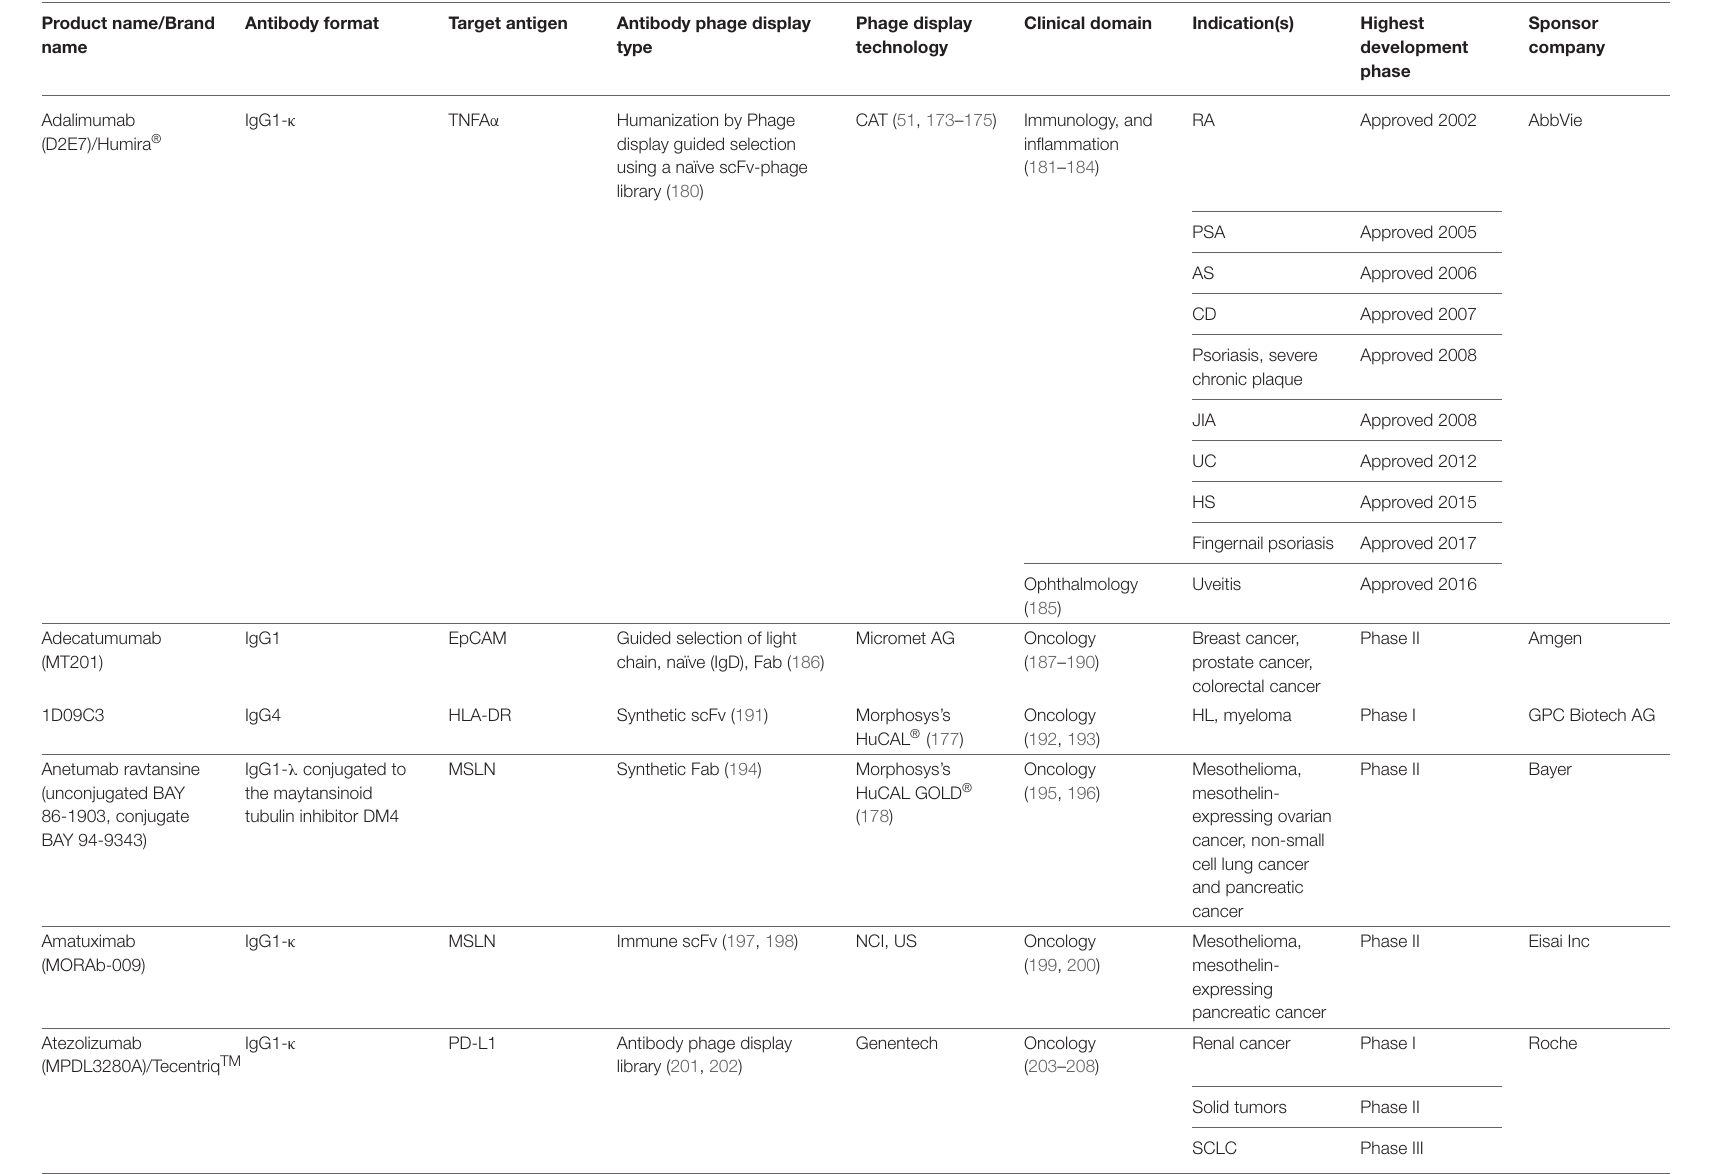
TABLE 2 | A list of phage display-derived therapeutic antibodies that either are approved or have been investigated clinical